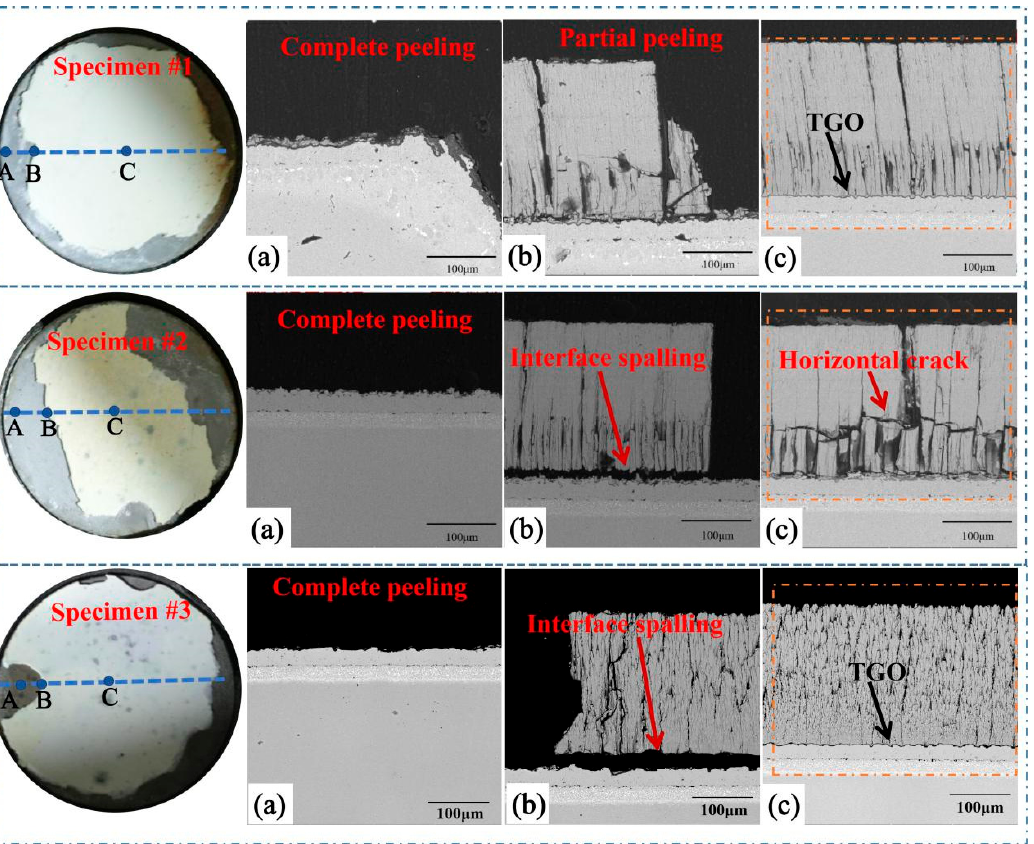
Figure 8. Cross-sectional SEM images of three TBC specimens after failure: ( a – c ) cross-sectional morphologies of areas A–C, respectively. Areas A, B, and C represent the complete peeling area, peeling edge area, non-peeling area, respectively. The corresponding microstructures are shown in ( a – c ).